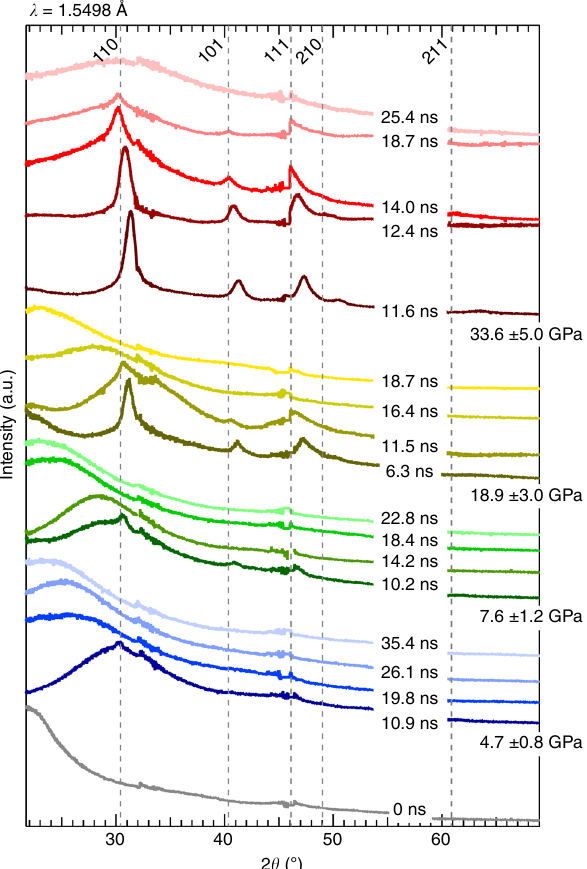
Fig. 2 Multiplot of XRD data. Stishovite peaks are labeled at the top; ambient condition positions (gray dashed lines). Traces are clustered according to maximum applied pressure with time delays listed on shock- release. Offset along the y axis and color scheme of the traces are arbitrary to enable viewing clarity. Discontinuities in the traces are seen at 32.5°, 46.0° and 58.0° 2 θ due to spacing between the mosaicked active areas of the